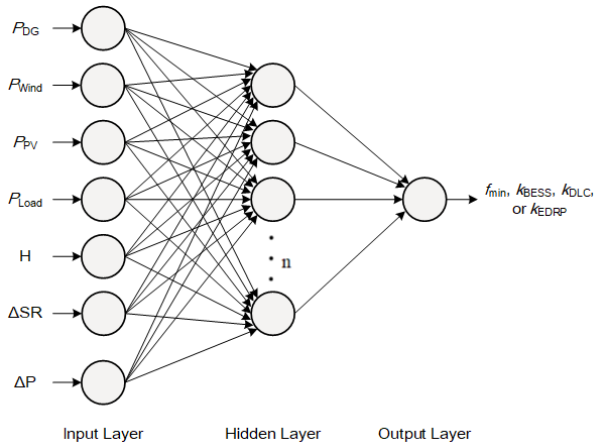
Figure 9. The frequency nadir and frequency support capability forecasting module using back-propagation artificial neural network (BP-ANN).